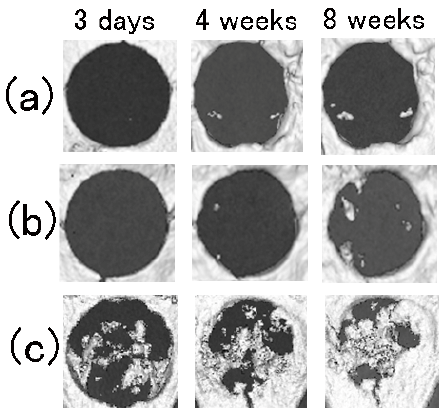
Figure 4. Micro-computed tomography (CT) images of cranial defects with and without implant materials (( a ): defect only (DEF), ( b ): P-COL, and ( c ): P-nHAP/COL)) at 3 days, 4 weeks, and 8 weeks after surgery.